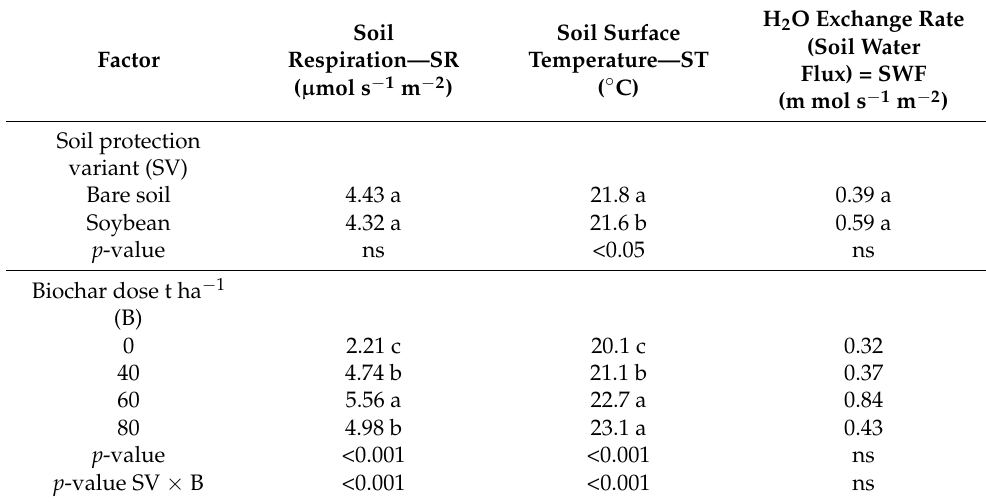
Table 4. Soil respiration activity, average soil temperature, and water vapor flow in the soil in the second year after biochar application, depending on the soil protection variant.